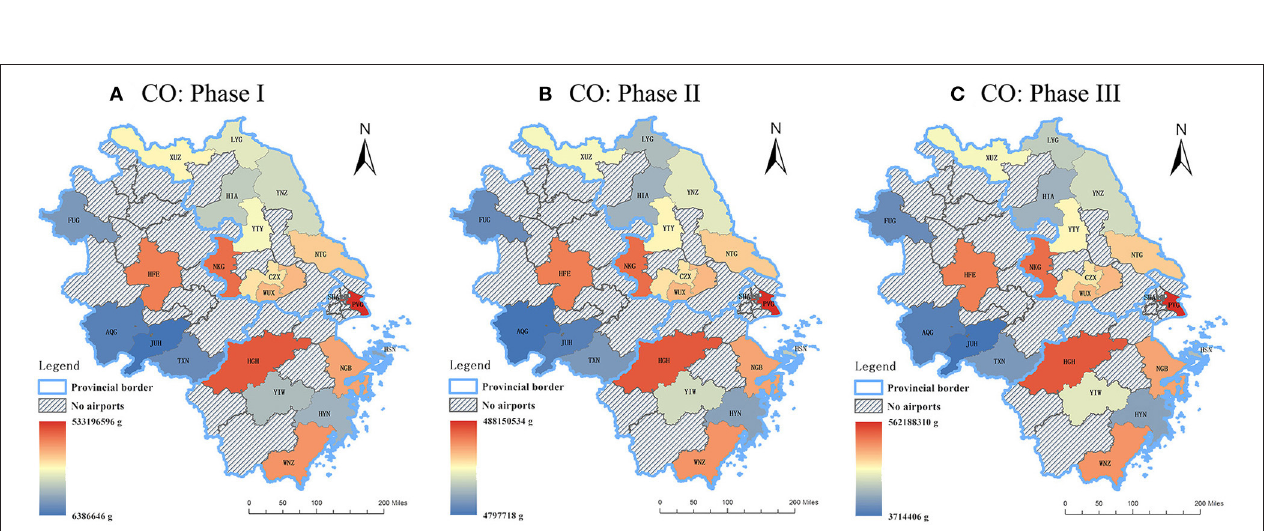
FIGURE 9 | The emission quantity of CO during the three phases of 2020. (A) Phase I: from the beginning of January to the end of April (B) Phase II: from the beginning of May to the end of August (C) Phase III: from the beginning of September to the end of